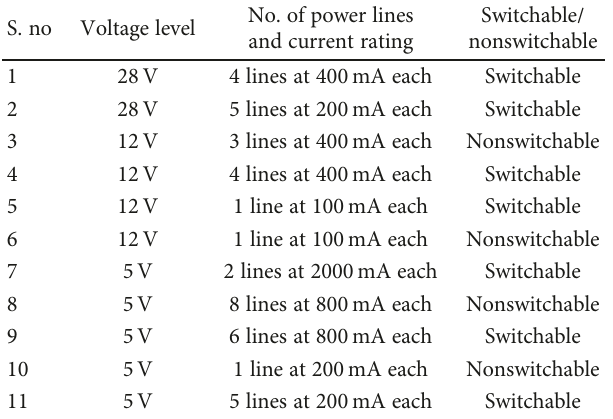
Figure 19: Design schematic of PDM.